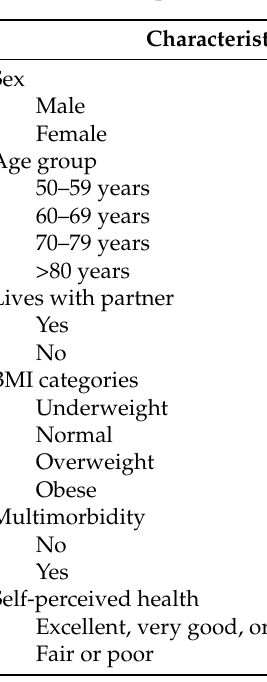
Table 1. Total sample characteristics at baseline, 2015 ( n =